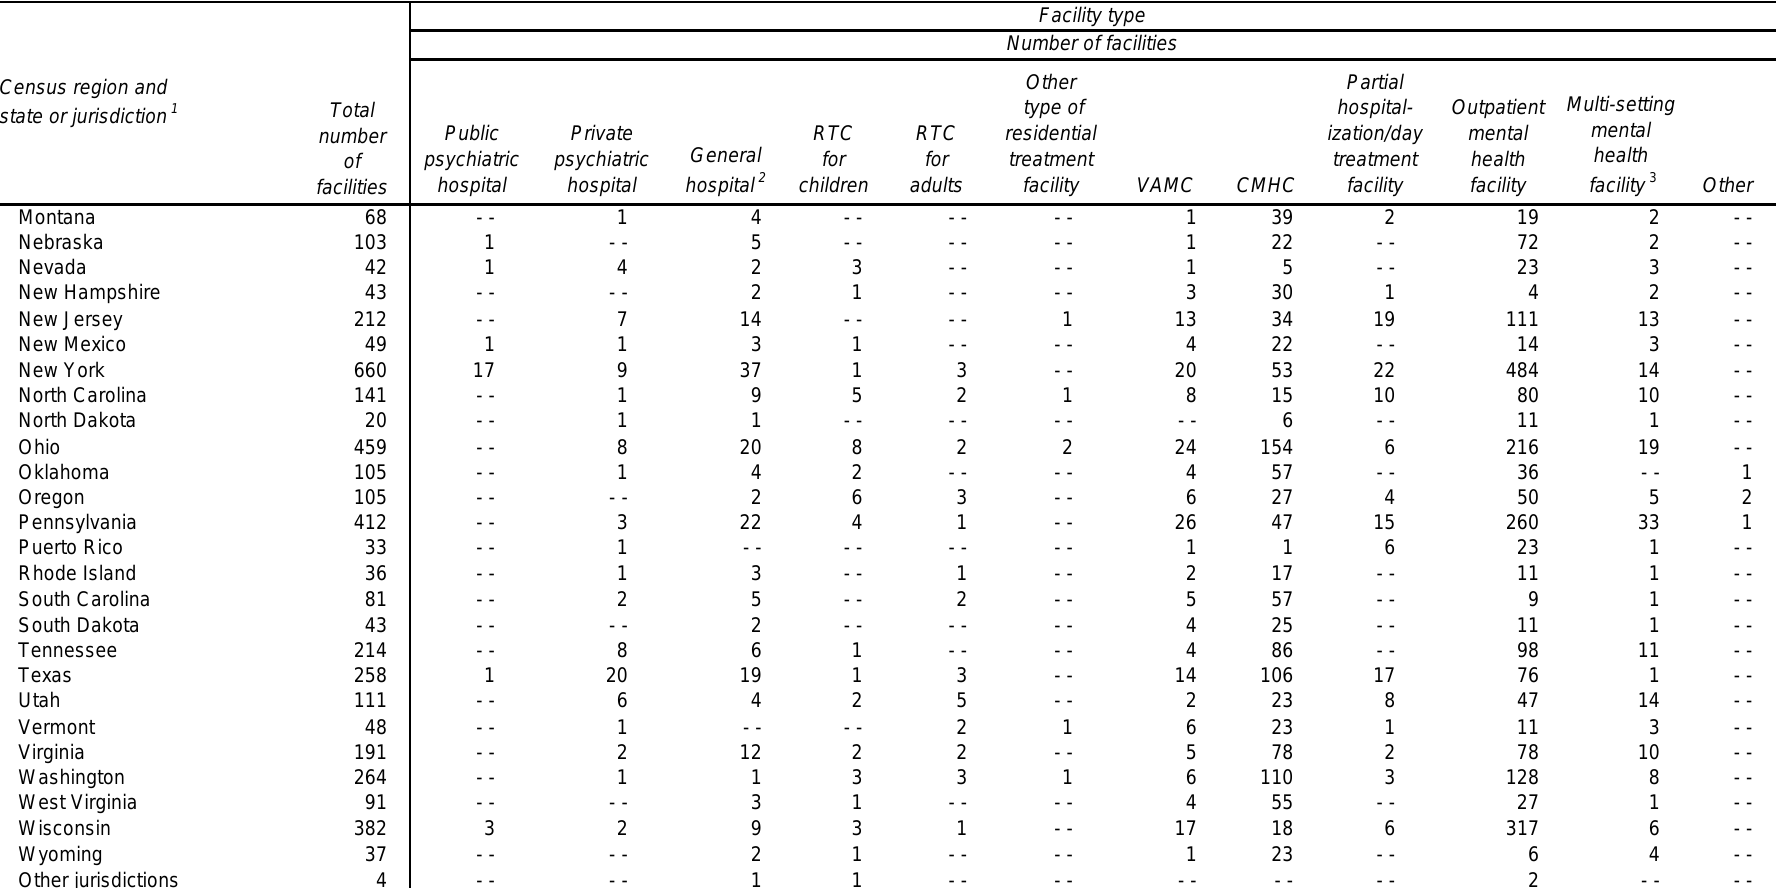
Table 3.6a. Mental health treatment facilities providing less than 24-hour outpatient treatment, by facility type, Census region, and state or